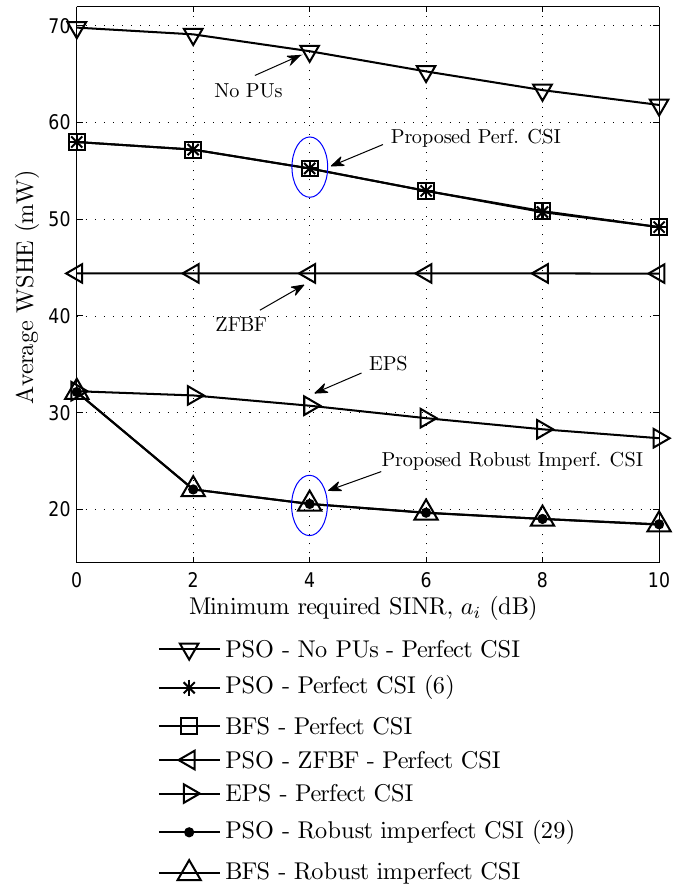
Figure 4. Average weighted sum harvested energy according to minimum required SINR. BFS: brute-force